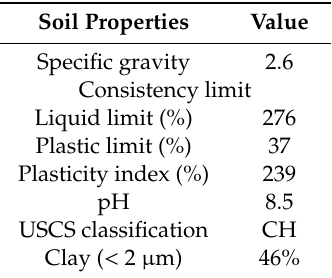
Table 1. Physical properties of the tested